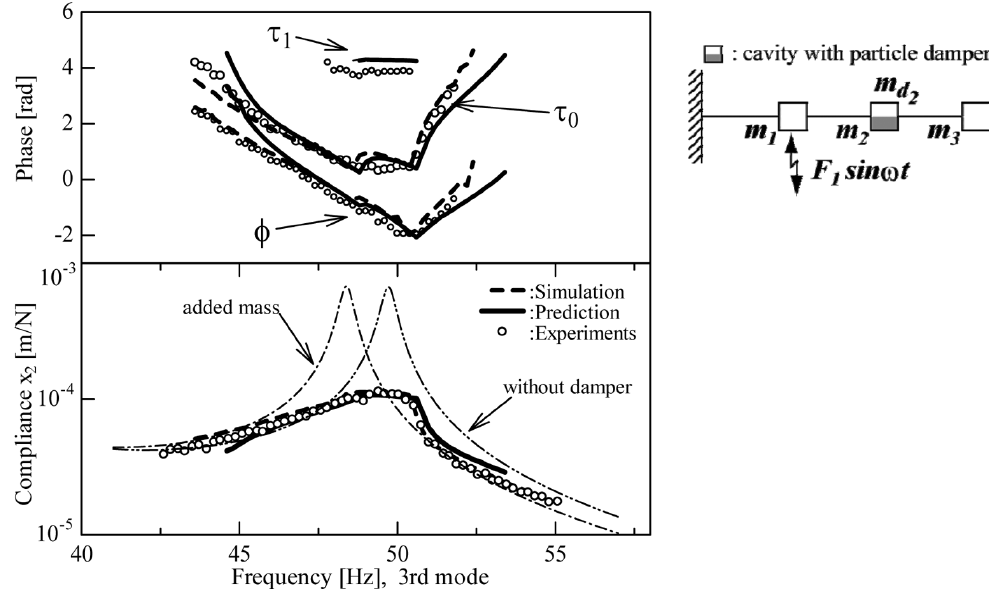
Fig. 9. Comparison between theory, experiment and simulation of 3rd mode response. ( µ d 2 = 6% , d 2 = 0 . 98[ mm ] ,j = 1 , 2 , 3 ,F 1 = 3 . 3[ N